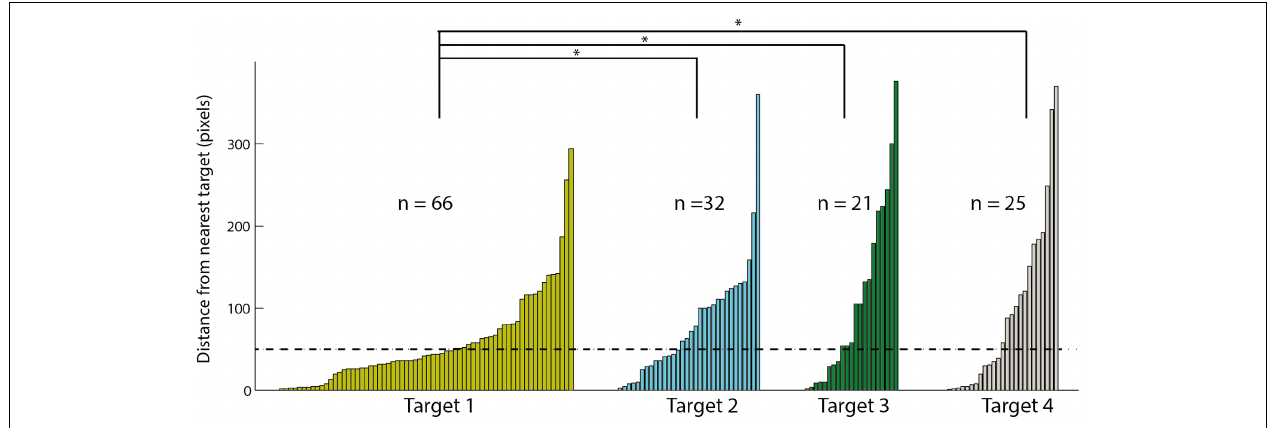
FIGURE 7 |The distances to the nearest visual target of all fixation points toward the arena. Data is divided to four targets based on the distance of the target to the speaker, target one is the closest to the speaker and target four the furthest. Within each target the results are